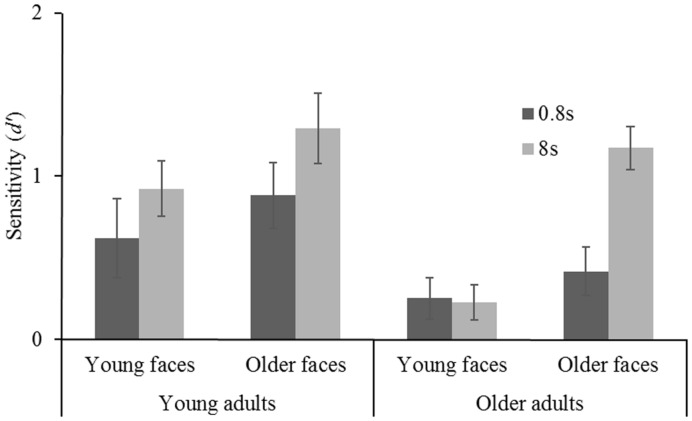
Face recognition performance (d′) for short (0.8 s) and long (8 s) exposure duration as a function of stimulus age (younger faces vs. older faces) for young adults and older adults. Error bars represent standard errors.